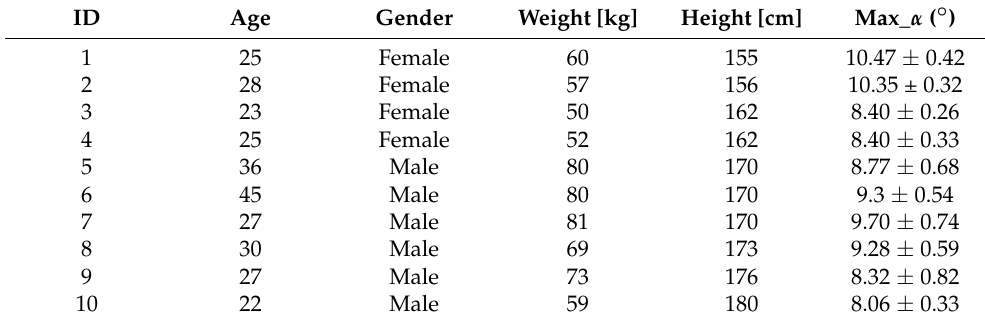
Table 1. The results of boundary conditions for ten participants.